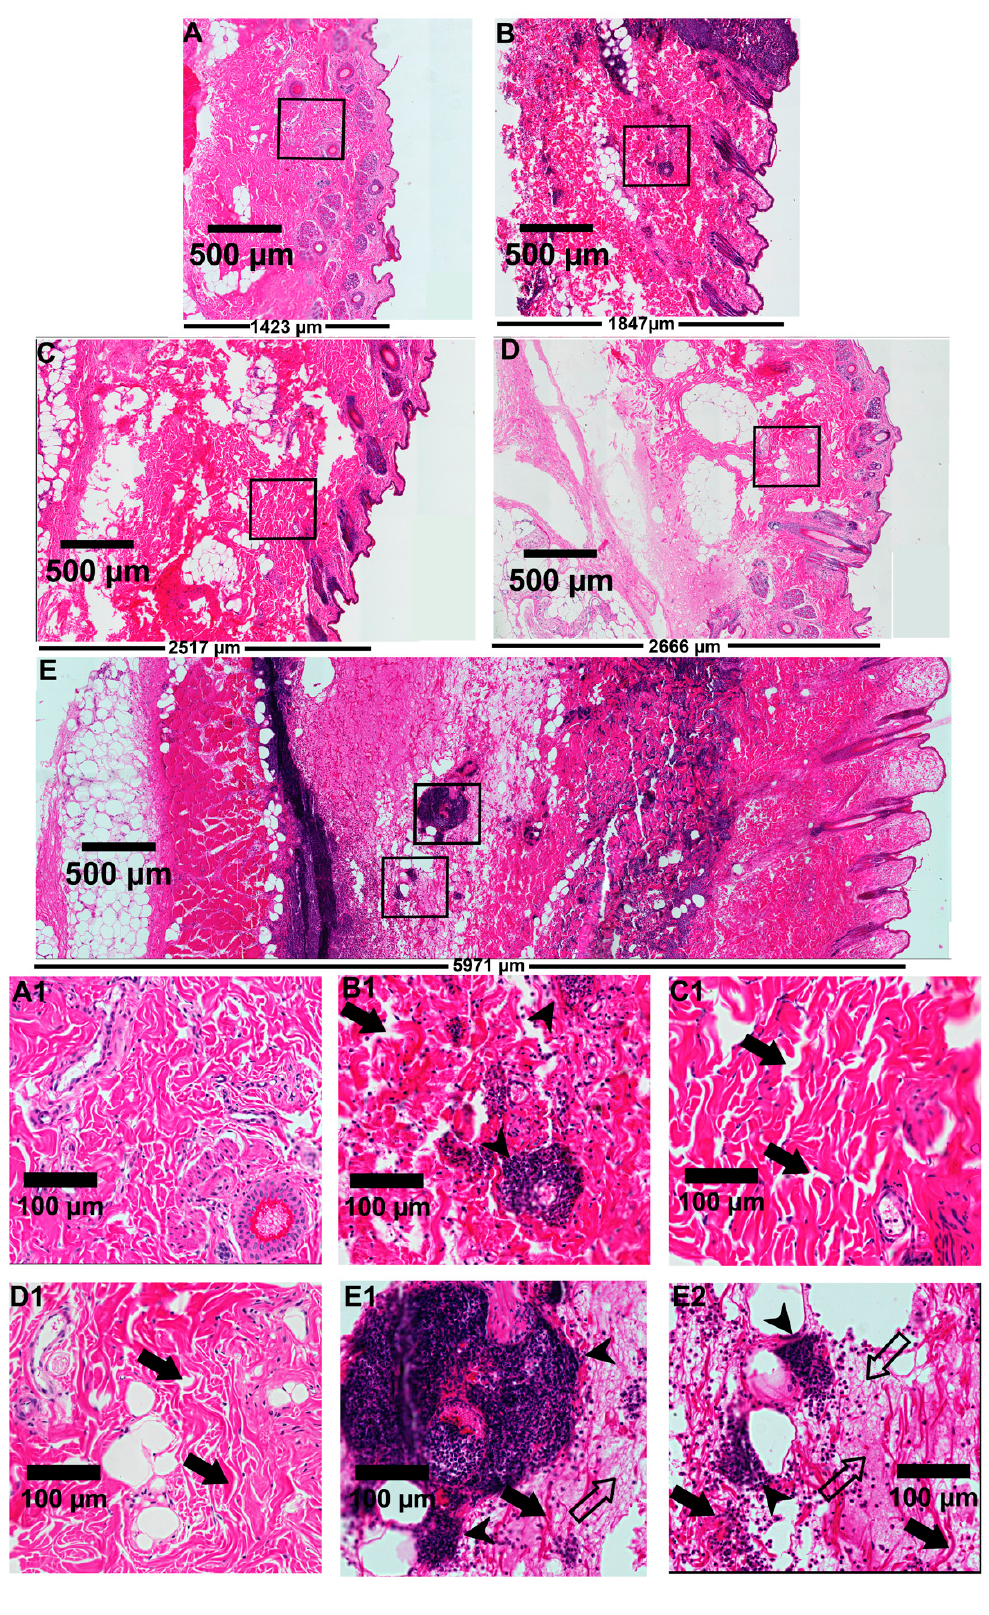
Figure 7. Microscopic evaluation of rabbit skin exposed to recombinant toxins (LiRecTCTP, LiRecDT1, or combined toxins LiRecTCTP/LiRecDT1). Light microscopic analysis of tissue sections